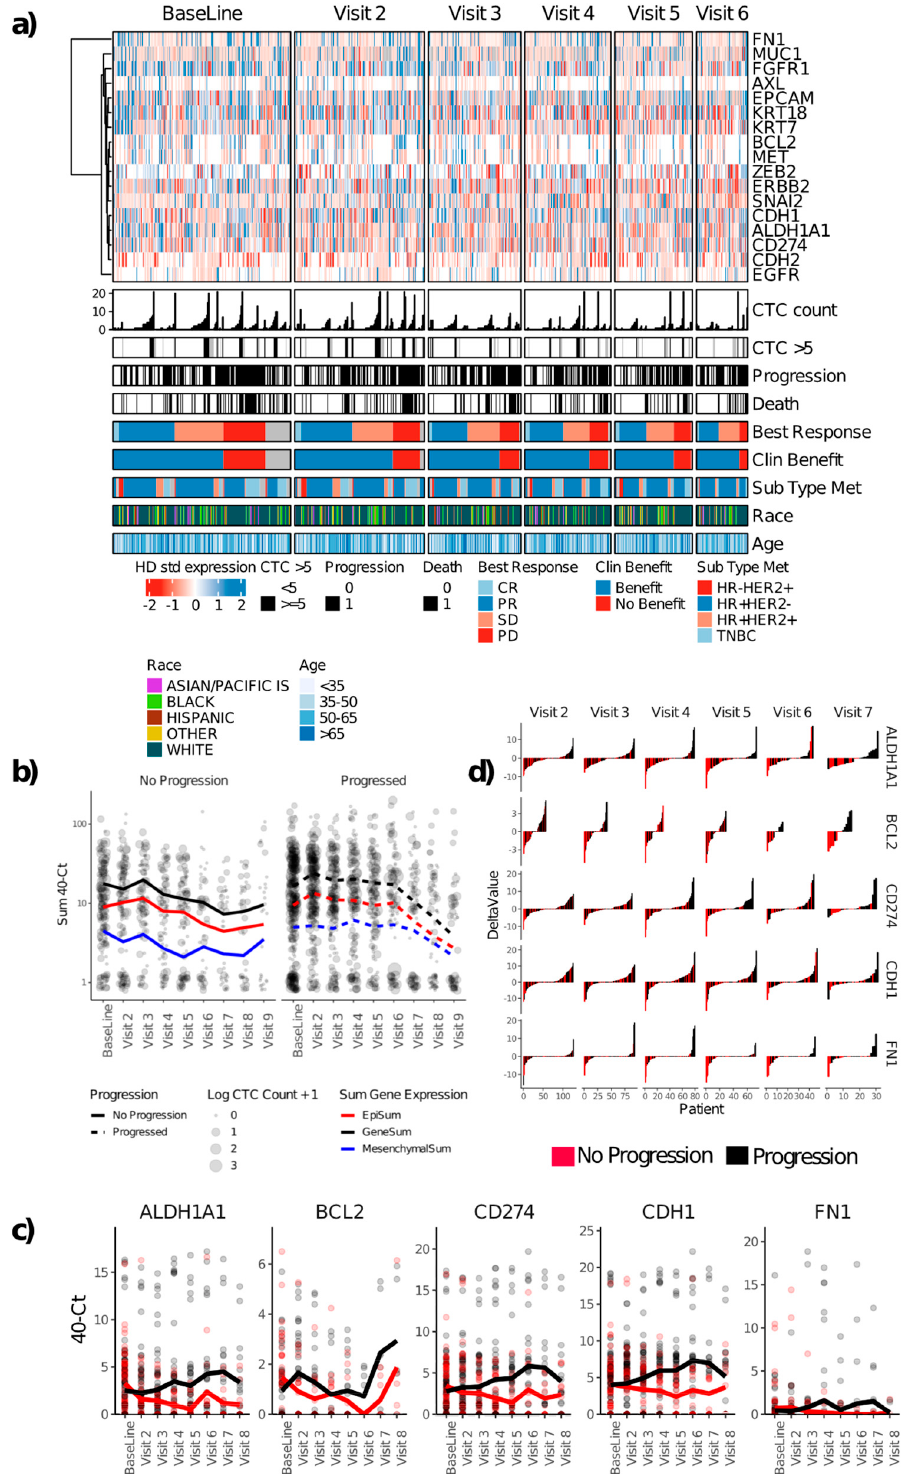
Figure 3. CTC gene expression. ( a ) Heat map of gene expression Z-score normalized to HD samples. ( b ) Mean sum of CTC-related gene expression (epithelial, mesenchymal, and total) stratified by progression. ( c ) Mean expression of 5 individual genes stratified by progression. ( d ) Waterfall plot showing a change in CTC-related gene expression from baseline for the same 5 genes. CTC, circulating tumor cell. CR, complete response; HR, hormone receptor (ER or PR); PD, progressive disease; PR, partial response; SD, stable disease; TNBC, triple negative (for ER, PR, and HER2).